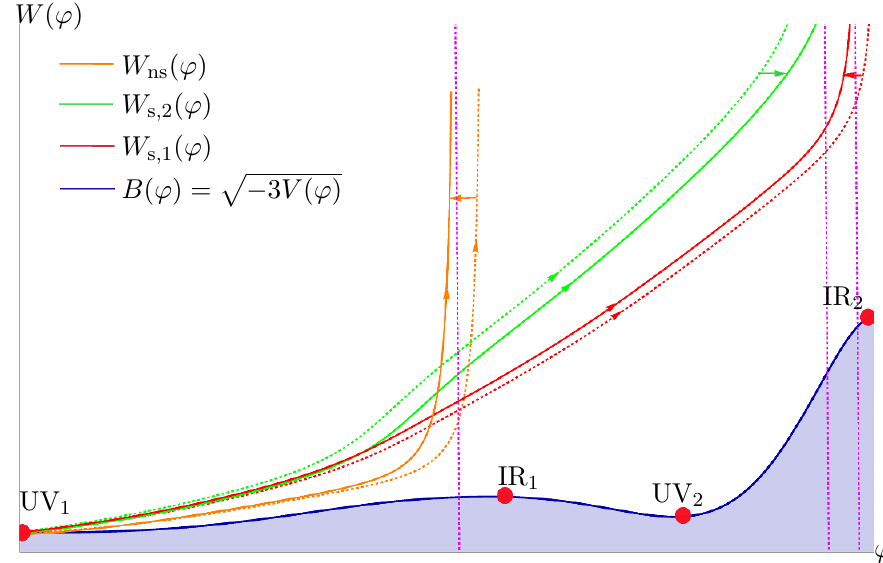
Figure 26. As the curvature is increased, IR end points of the skipping (cid:13)ows move toward each other. The non-skipping IR end point moves closer to UV 1